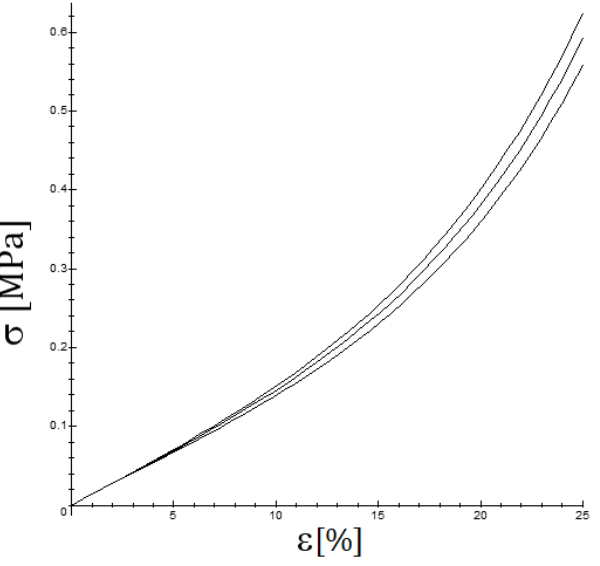
Figure 7. The influence of the strain rate on the stress–strain curve for ˙ ε = 0.1/ τ 0 ,0.2/ τ 0 y 0.5/ τ 0 (the upper curve occurs for the highest strain rate and the lower one for the lowest strain rate); the following values have been considered in the graph: b 0 = 8, c = 0.10, g 1 = 0.40.